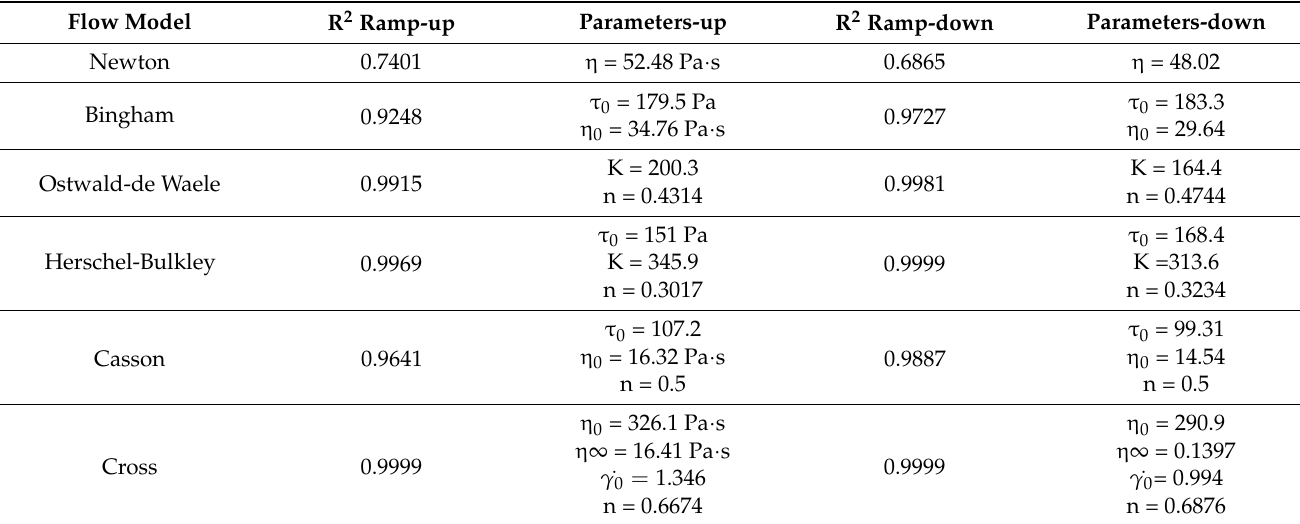
Table A2. Mathematical models of the flow characterization by regression analysis.